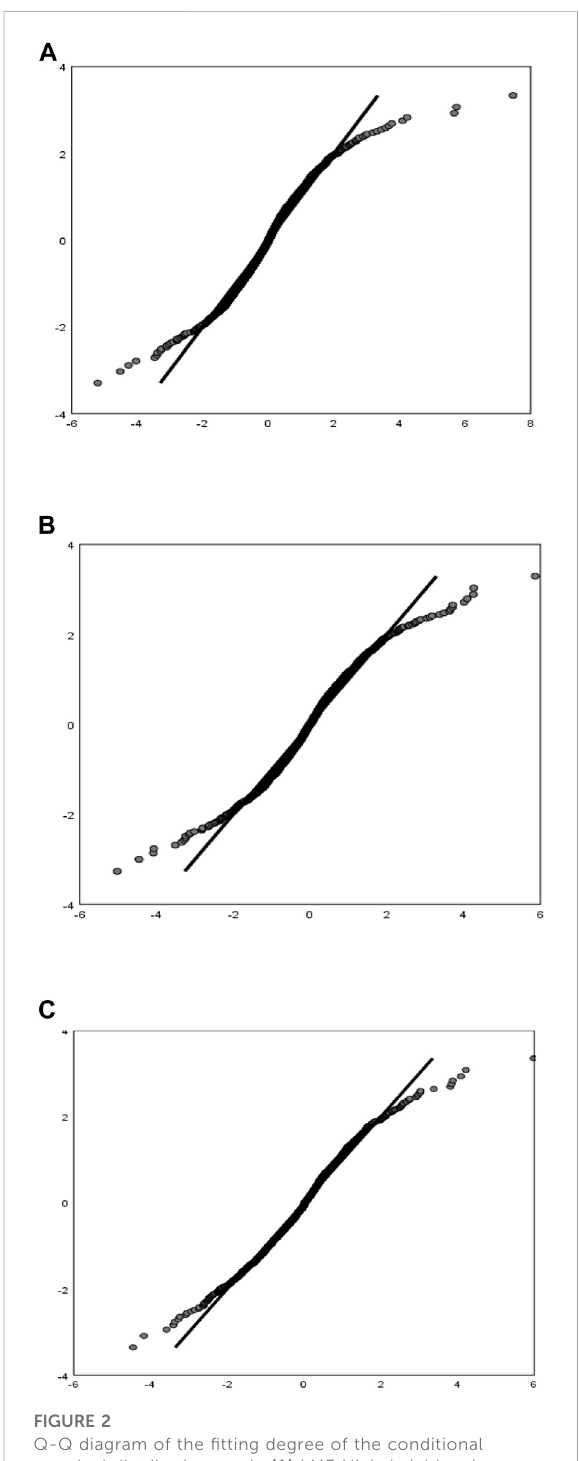
FIGURE 2 Q-Q diagram of the fi tting degree of the conditional marginal distribution mode (A) LME Nickel yield series, (B) SMM Nickel yield series, (C) The spot price yield series. Note: The horizontal axis represents the quantile of the normal distribution. The vertical axis represents the quantile of the series of yields after a fi rst-order difference.